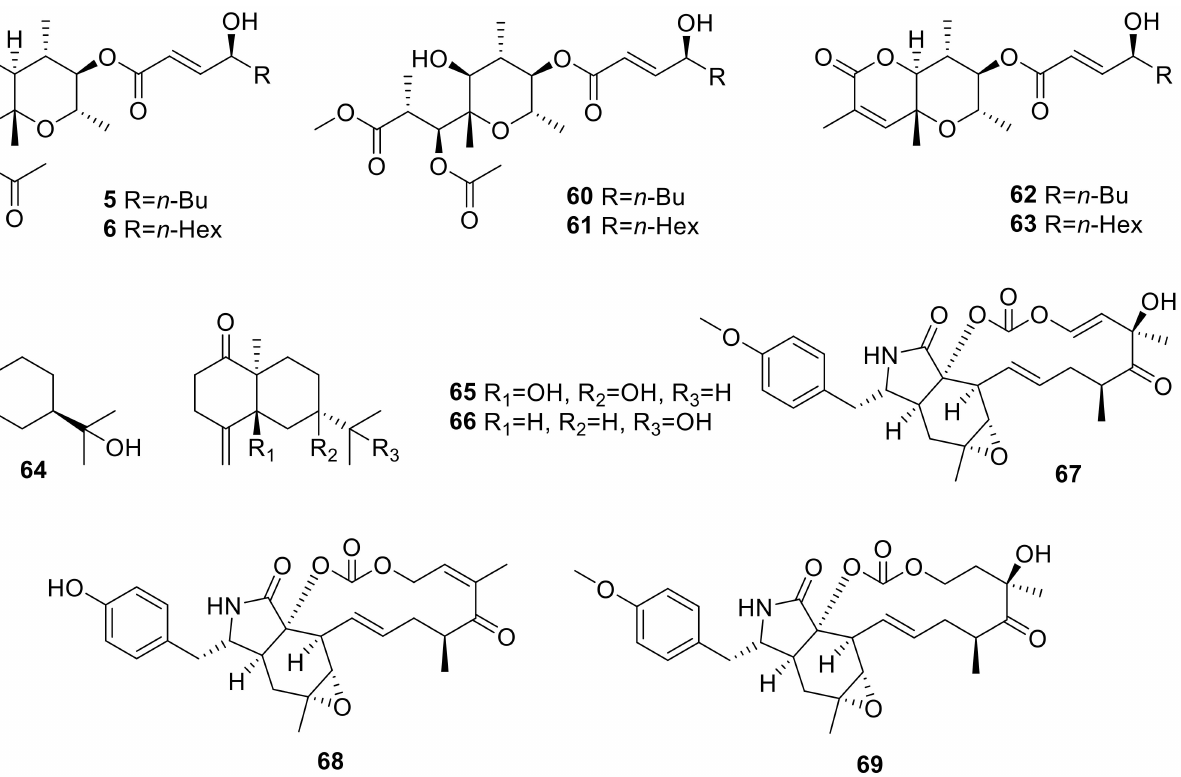
(Figure 18): the new sesquiterpenes 1-keto-4 α ,15-epoxyeudesm-11-ol ( 64 ) and